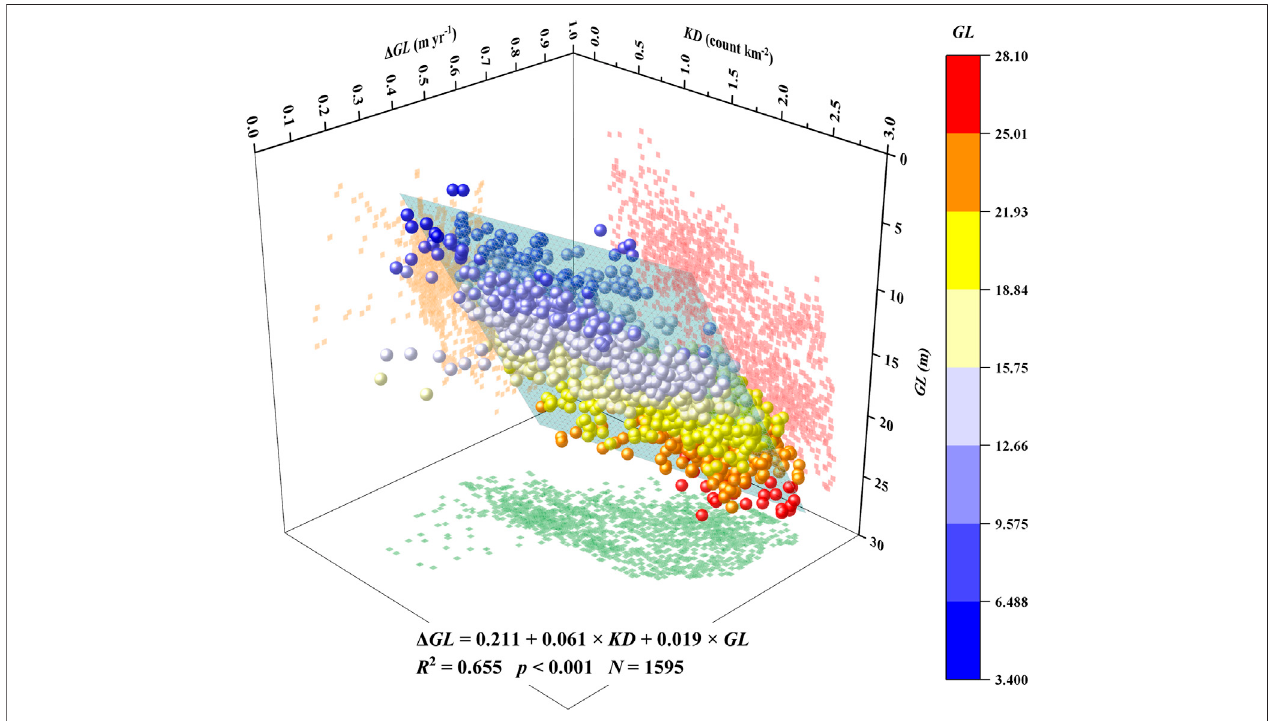
FIGURE 4 | Relationships among Δ GL (the change of the groundwater level from April 2019 to October 2021), KD (kernel density in 2020), and GL (the mean in Octobers). Each sphere represented a CPI well. The plane function is represented as z = z 0 + a*x + b*y, and all parameters of z 0 , a, and b are signi fi cant ( p < 0.001).